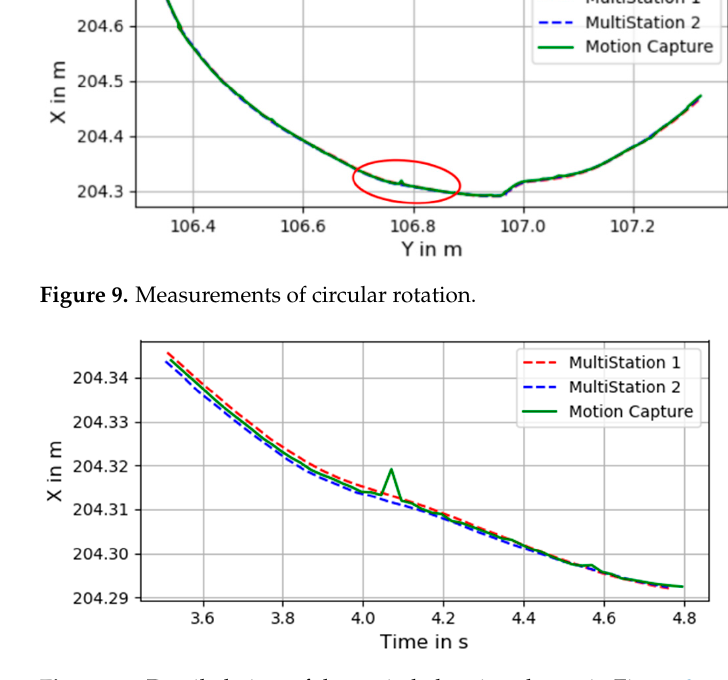
Figure 10. Detailed view of the encircled region shown in Figure 9.